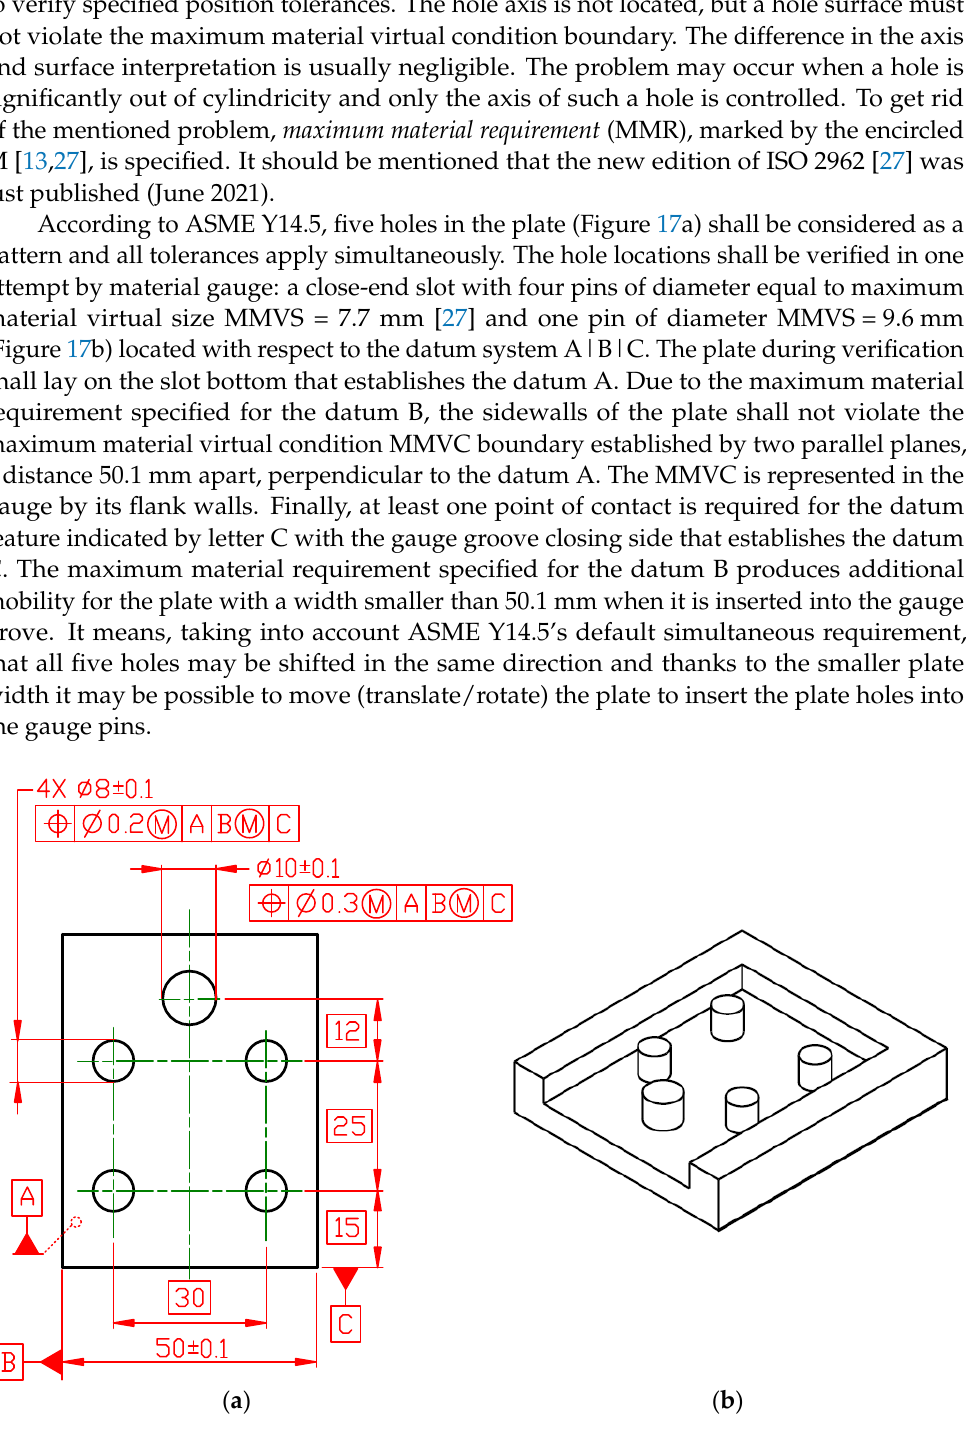
Figure 17. ( a ) Two position tolerances shall be verified simultaneously (ASME Y14.5); ( b ) the material gauge. material